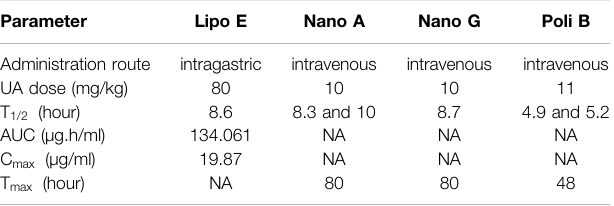
TABLE 4 | Pharmacokinetic data summary of preclinical studies of nanoparticles containing UA. Parameter